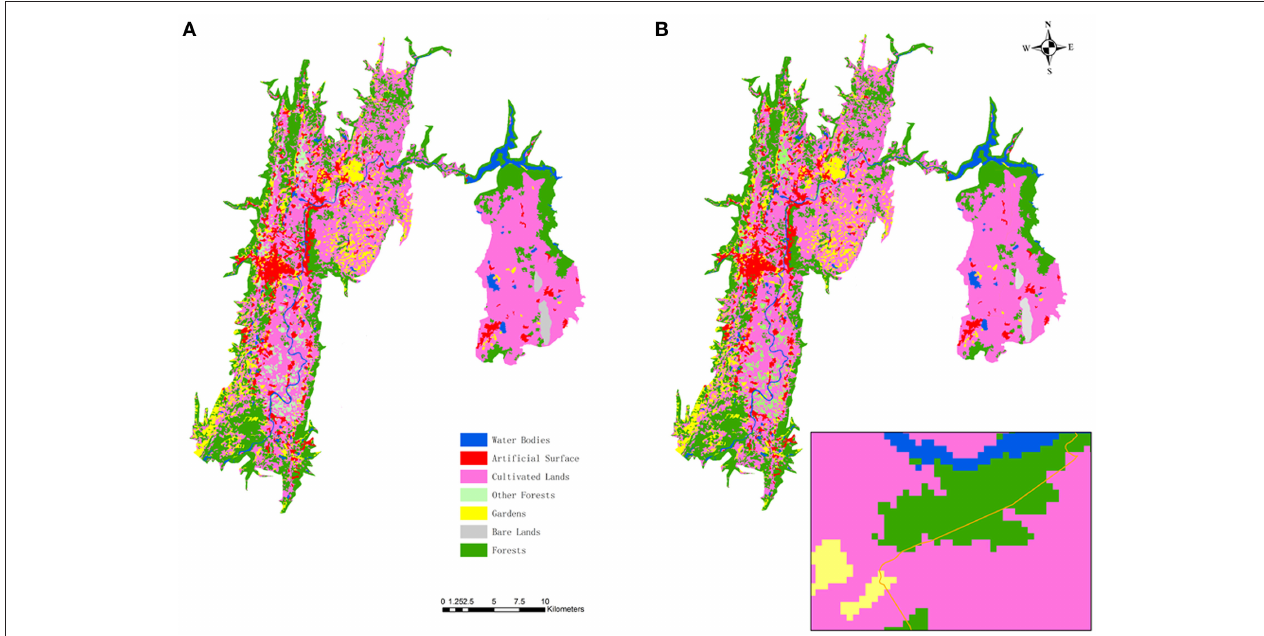
FIGURE 2 | The land-use changes before (A) and after (B) the Chaishitan water conservancy established.